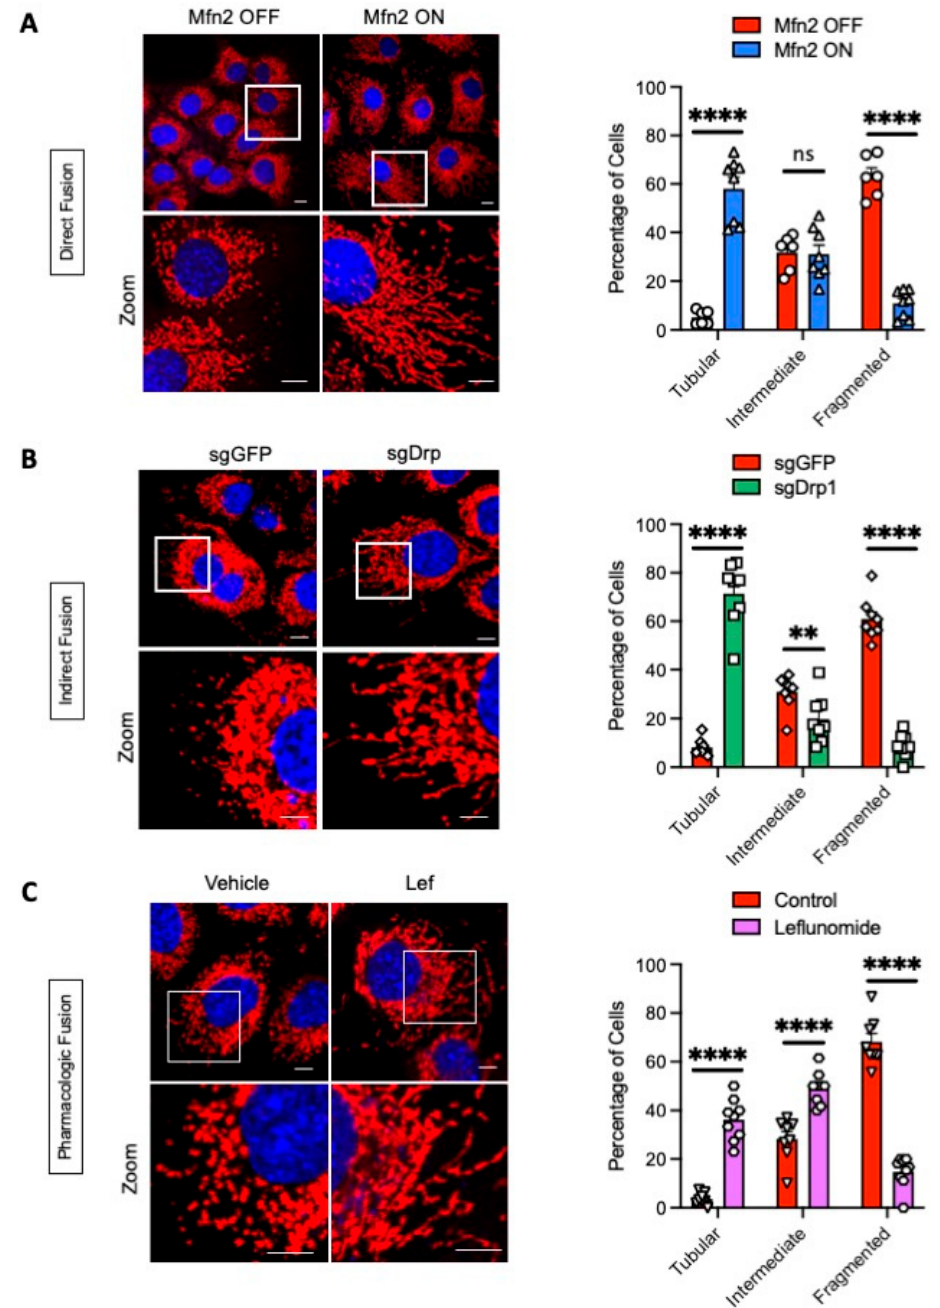
Figure 2. Confocal microscopy reveals changes in mitochondrial morphology in KPC cells after multi- ple independent fusion induction modalities. ( A ) Doxycycline-induced overexpression of Mfn2 (blue triangles) significantly increased tubular morphology while significantly decreasing fragmented mi- tochondria when compared to its Tet-Off control (red circles). ( B ) Indirect fusion through abrogation of Drp1 (green squares) significantly increased tubular morphology while significantly decreasing intermediate and fragmented mitochondria when compared to sgGFP controls (red diamonds). ( C ) Pharmacologic induction of fusion with Lef (purple hexagons) significantly increased tubular and intermediate mitochondrial morphology while decreasing fragmented morphology when compared to vehicle controls (red triangles). Red fluorescence represents mitochondria; blue fluorescence repre- sents DAPI-labeled nuclei. Mitochondrial morphology quantified using n = 100–200 cells. Statistical analysis by Student’s t -test, **** p < 0.0001, ** p < 0.01. Original magnification, × 60. Scale bar = 10 µ m. Data presented as mean ±